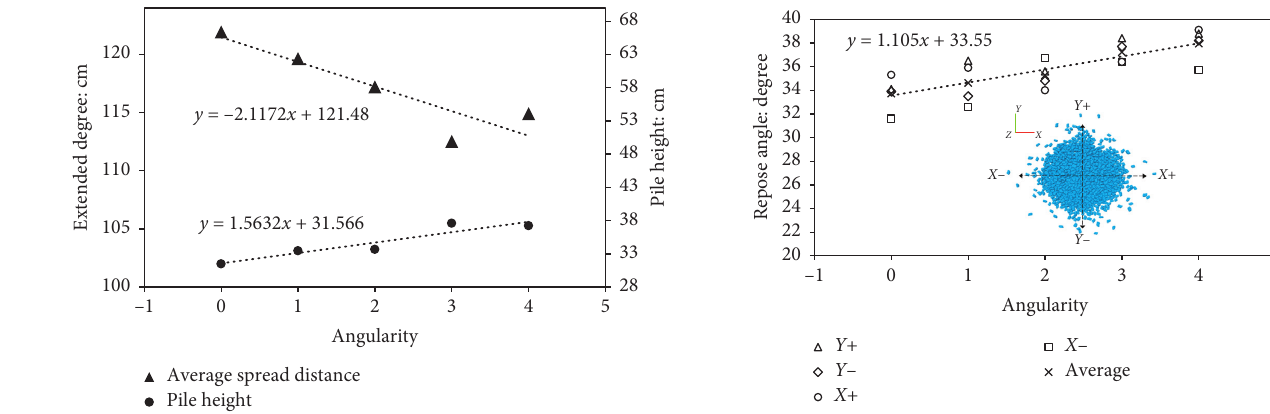
Figure 13: Angle of repose varies with